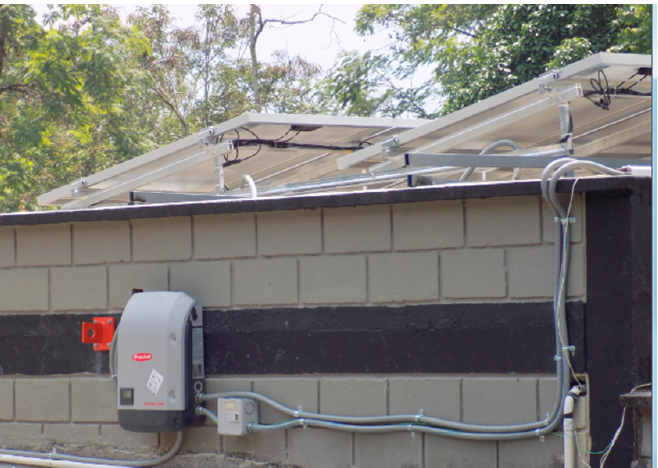
Figure 3. Photovoltaic system on-roof devices.